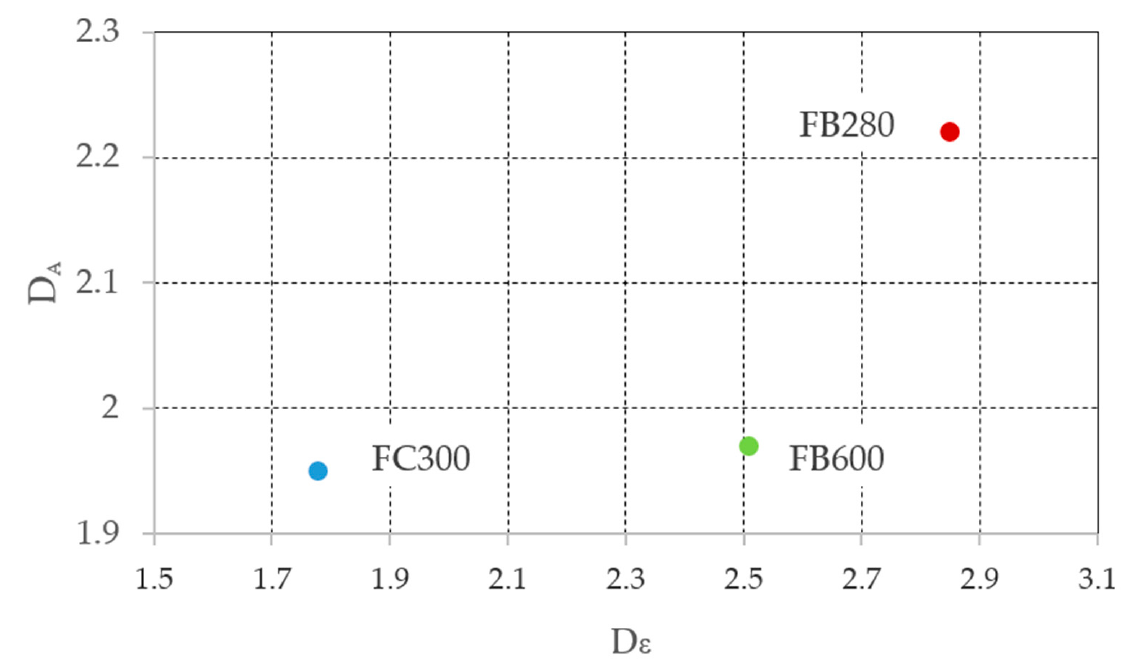
Figure 9. Relationship between the ductility measured by strain and by strain energy density for the three reinforcement types.